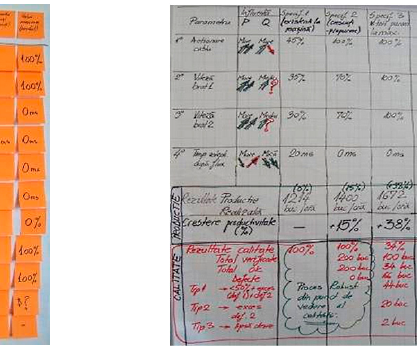
Figure 4. Analysis of parameters and their influence on quality and productivity.